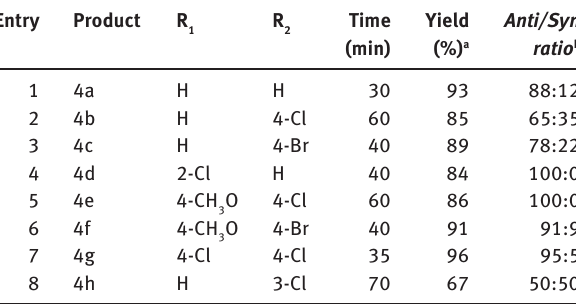
Table 2 Three-component Mannich reactions of aldehydes, amines, and ketone catalyzed by PPA/SiO